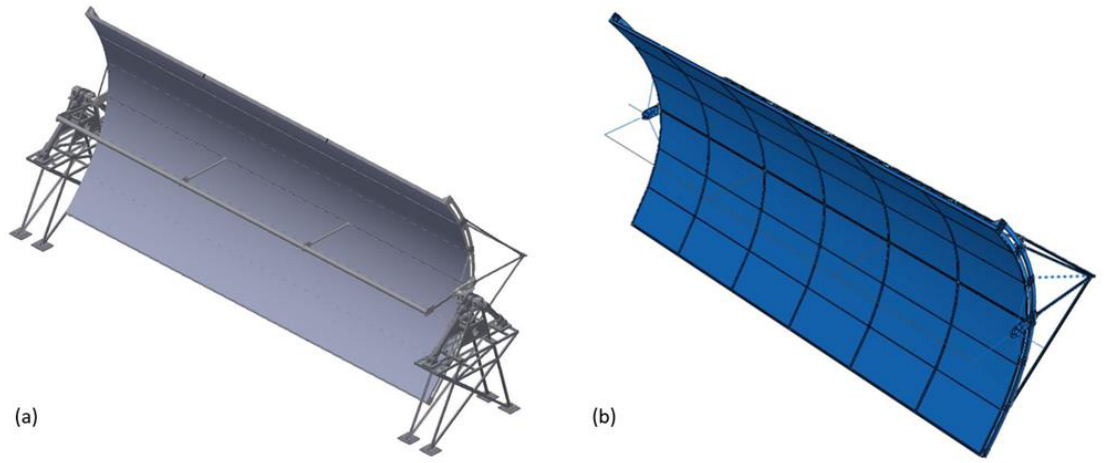
Figure 1. ( a ) Computer aided design (CAD) model. ( b ) Finite element model.